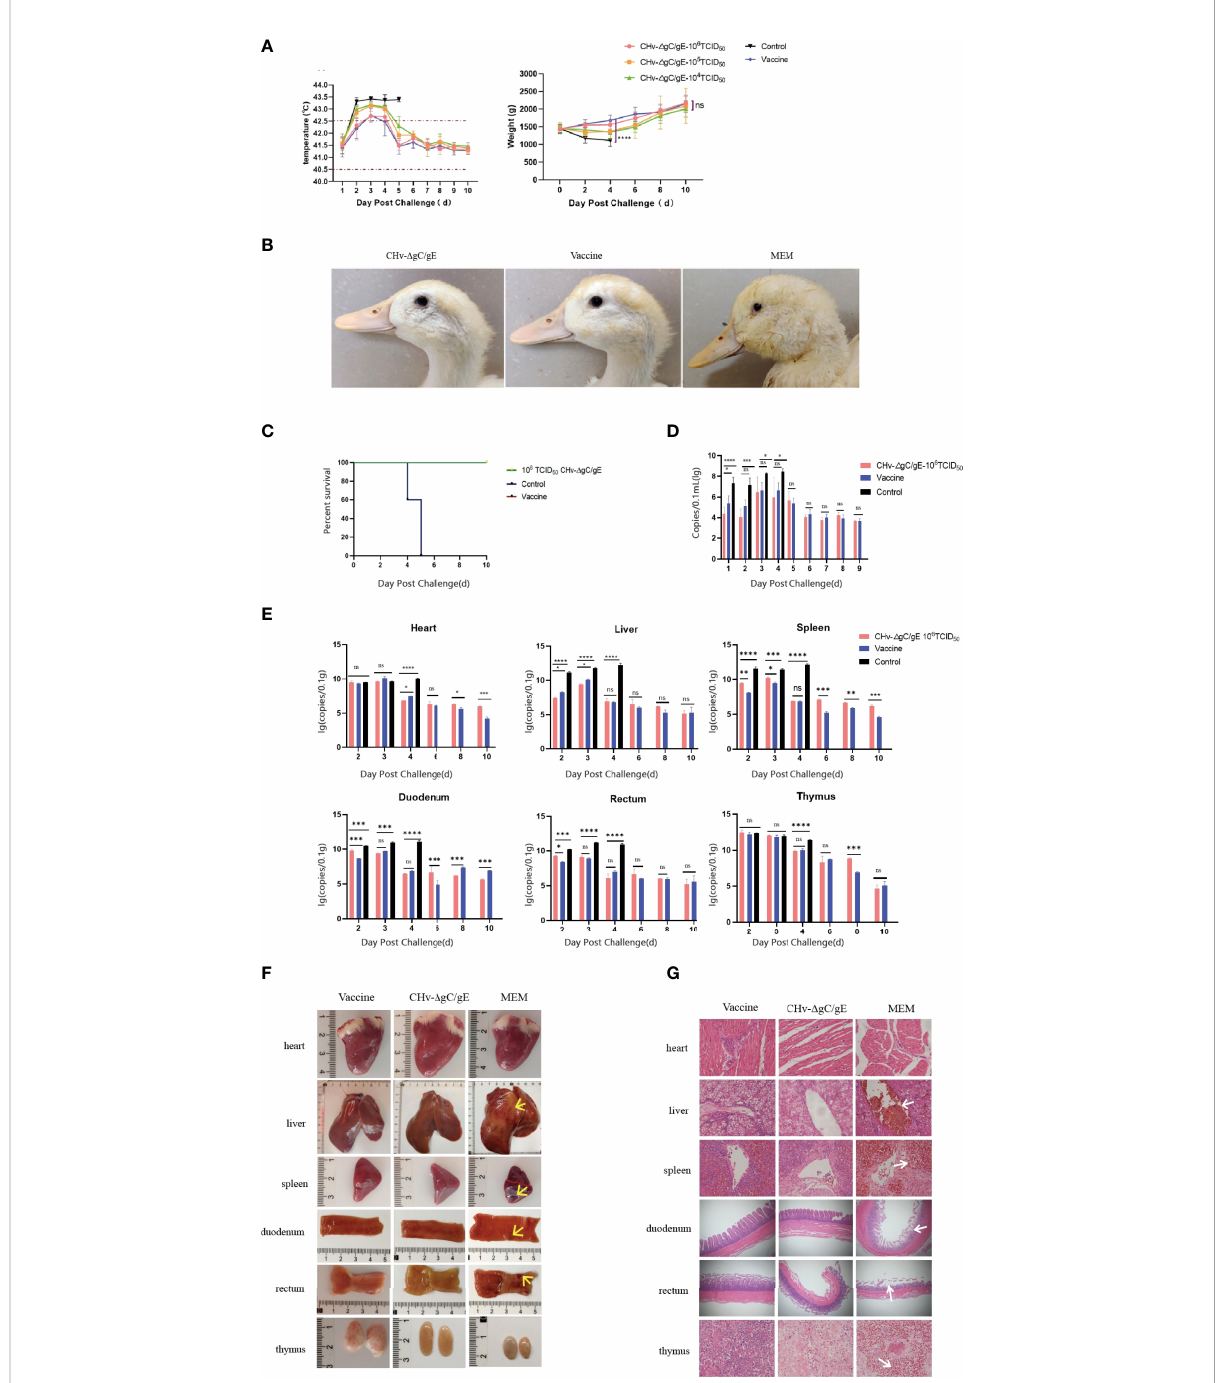
FIGURE 5 Protective ef fi cacy of CHv- D gC/gE against lethal CHv challenge in ducklings. (A) Rectal temperatures and body weight changes of ducklings challenged after immunization. (B) Clinical symptoms of immunized ducklings after challenge with 100 LD 50 CHv. (C) Survival curves of ducklings after challenge with 100 LD 50 CHv. (D) Rectal viral excretion by ducklings after challenge with 100 LD 50 CHv. (E) Quanti fi cation of viral DNA loads in heart, liver,spleen, duodenum, rectum and thymus tissues of the vaccinated duckings after challenge. (F) Postmortem examination of ducklings in each group at 6 dpi. There are obvious bleeding, congestion, ulcers and other lesions at the arrow. (G) Histological analysis of heart, liver,spleen, duodenum, rectum and thymus from the indicated groups after challenge with CHv- D gC/gE, Vaccine or MEM (control) (hematoxylin and eosin staining, 100× magni fi cation). *p<0.05; **p<0.01; ***p<0.001; ****p<0.0001; and ns, not signi fi